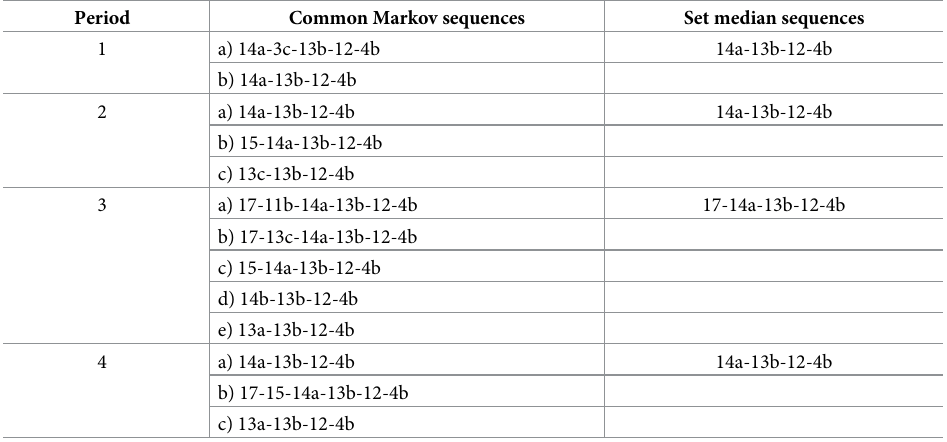
Table 3. Extracted song sequences using Markov matrices and set median